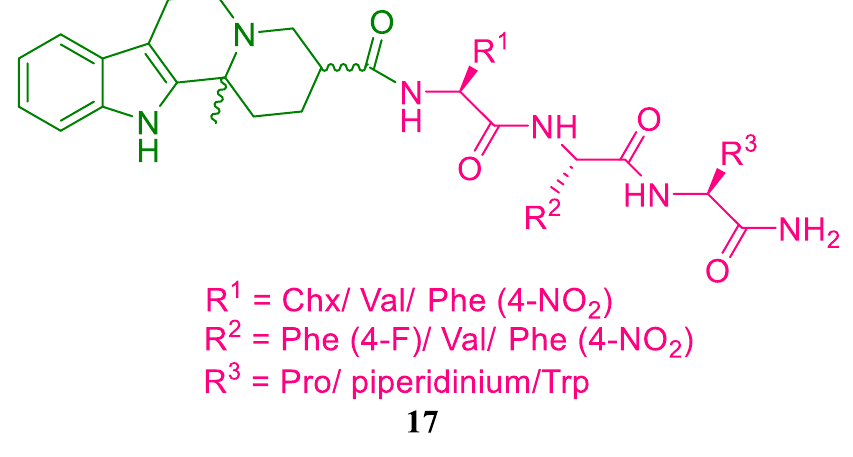
Figure 25. Indoloquinolizidine-peptide hybrids.